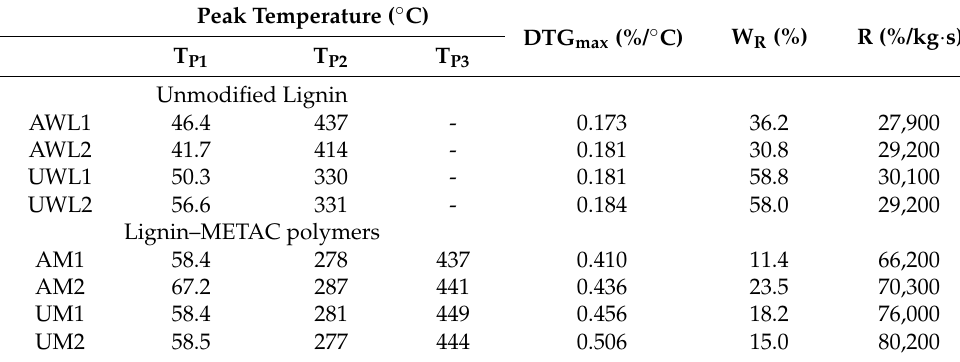
Table 4. Peak weight loss temperature (T p ), integrated weight loss (DTG maz ), residual mass (W R ), and reactivity index (R) of unmodified lignin and lignin – METAC polymers determined by TGA (Figures S4 and S5).